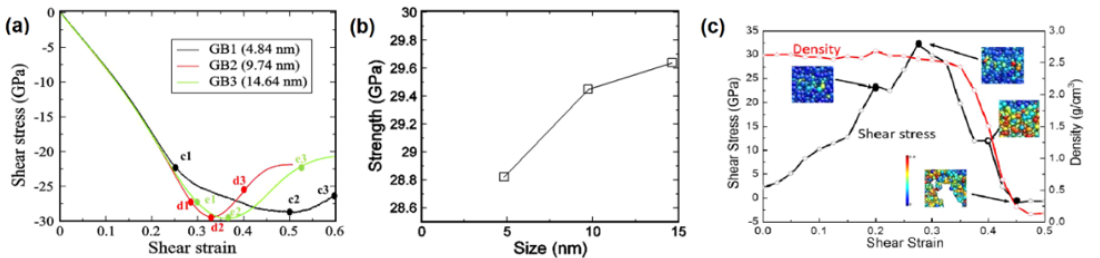
Figure 2. ( a ) Three n-B 4 C GB models under finite shear deformation at 0.1 ps − 1 shear rate. ( b ) The shear strength–size curve of three n-B 4 C GB models. ( c ) Shear stress and density–strain curve at TJPs. Reproduced with permission from [76]. Copyright 2022